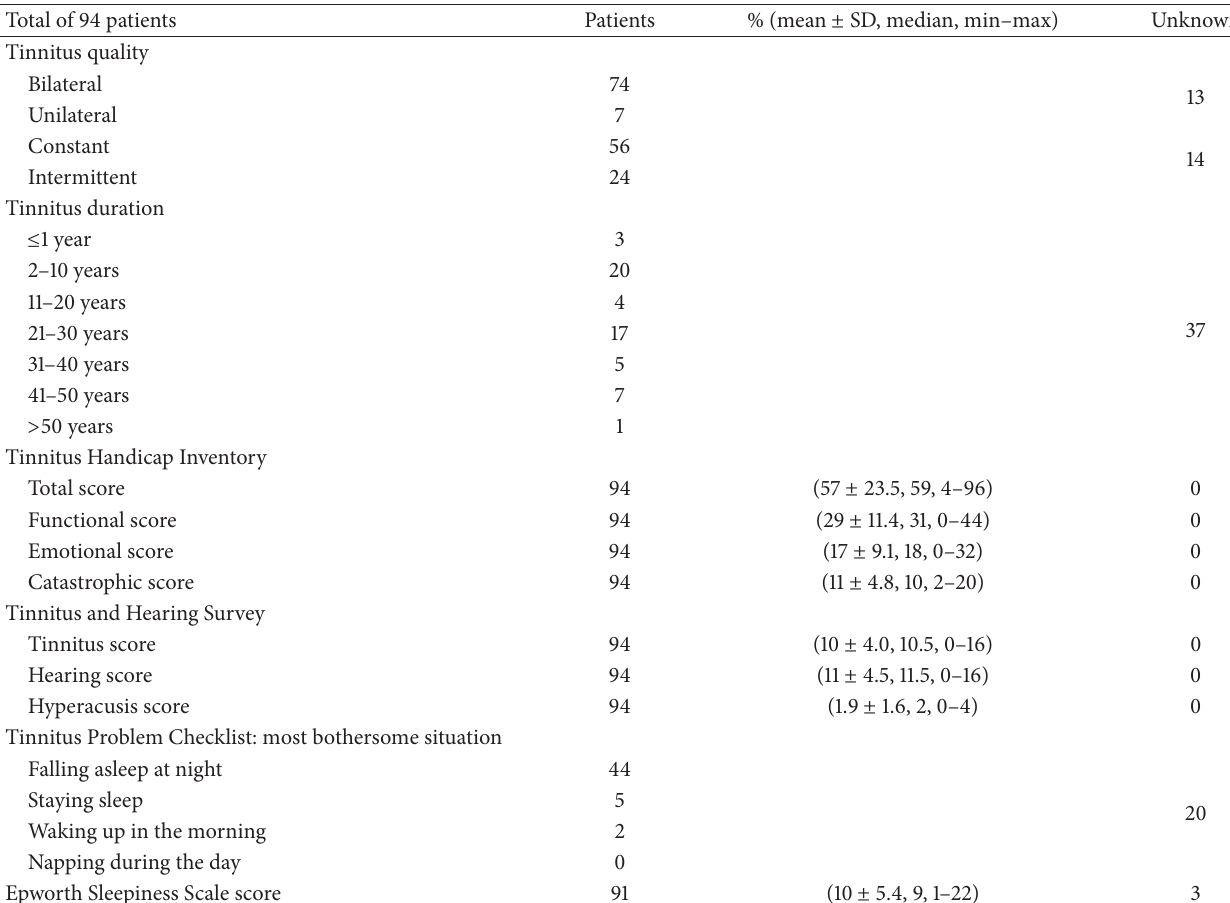
Table 2: Tinnitus